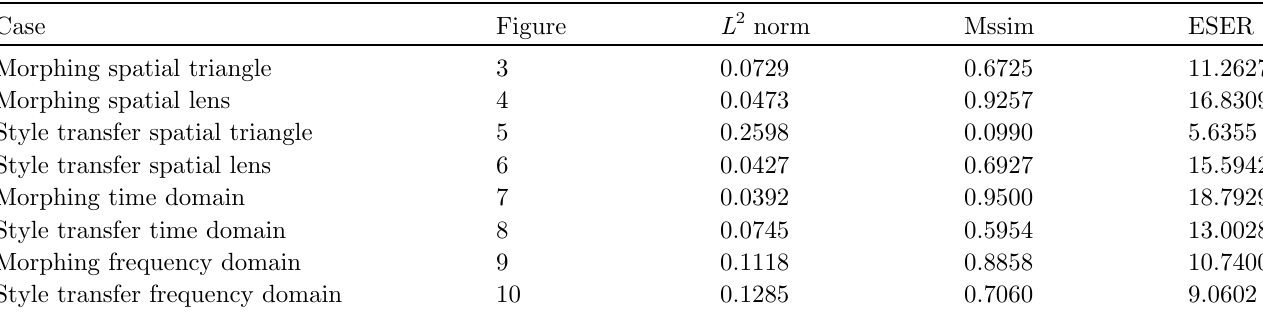
Table 1. Values of three metrics for morphing and style transfer experiments: L 2 norm, Mssim and ESER. Case Figure L 2